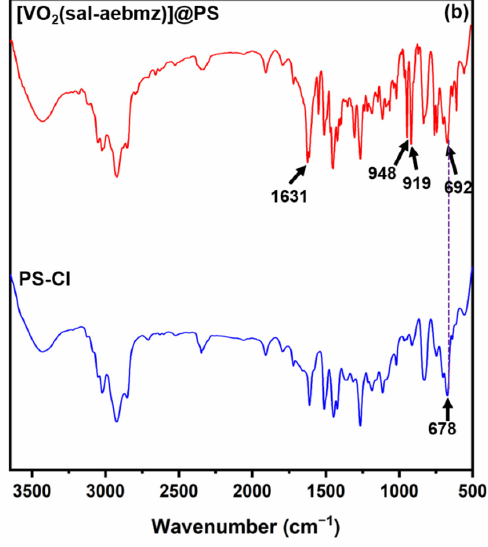
Figure 2. ( a ) FT-IR spectra of ligand Hsal-aebmz ( I ) and [V V O 2 (sal-aebmz)] ( 1 ). ( b ) FT-IR spectra of PS-Cl and heterogeneous catalyst [V V O 2 (sal-aebmz)]@PS ( 2 ).